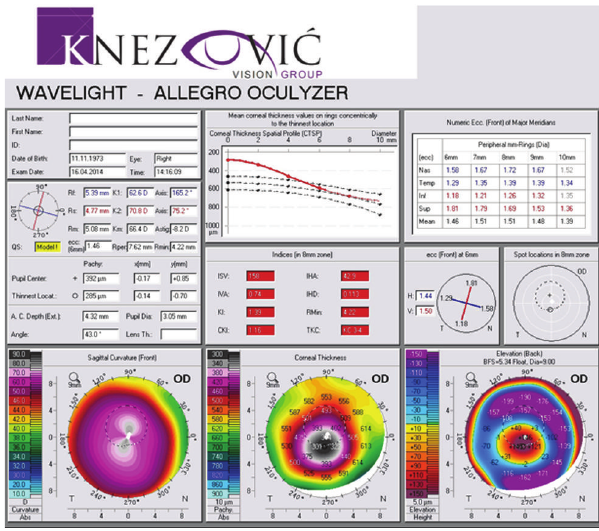
Figure 6: PCAM first examination, right eye.